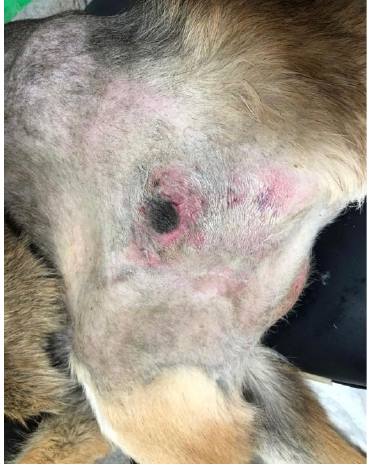
Figure 4 . Pressure sore in the femur greater trochanter region of a dog.